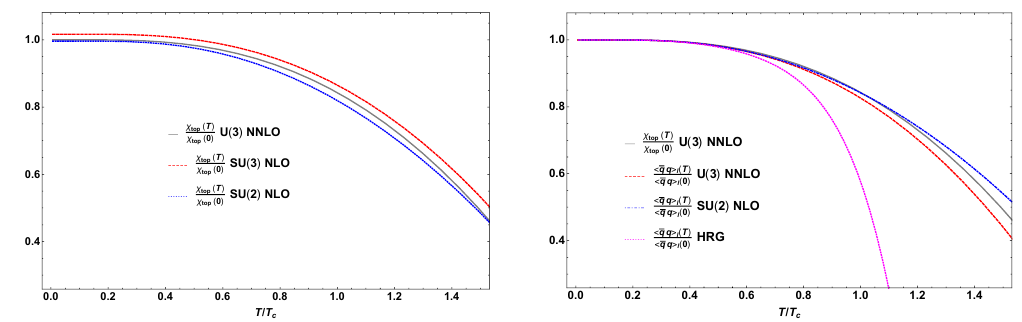
Figure 5 . Left: comparison of the U(3), SU(3) and SU(2) limits for the topological susceptibil- ity. Right: comparison of the topological susceptibility scaling at (cid:12)nite temperature with various approaches of the light quark condensate